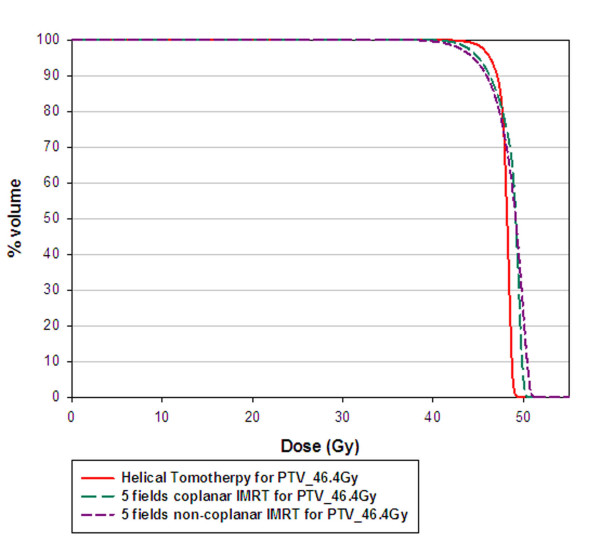
Dose-volume histogram of planning-target volume for one representative patient undergoing coplanar intensity-modulated radiotherapy (IMRT), noncoplanar IMRT, and helical tomotherapy.